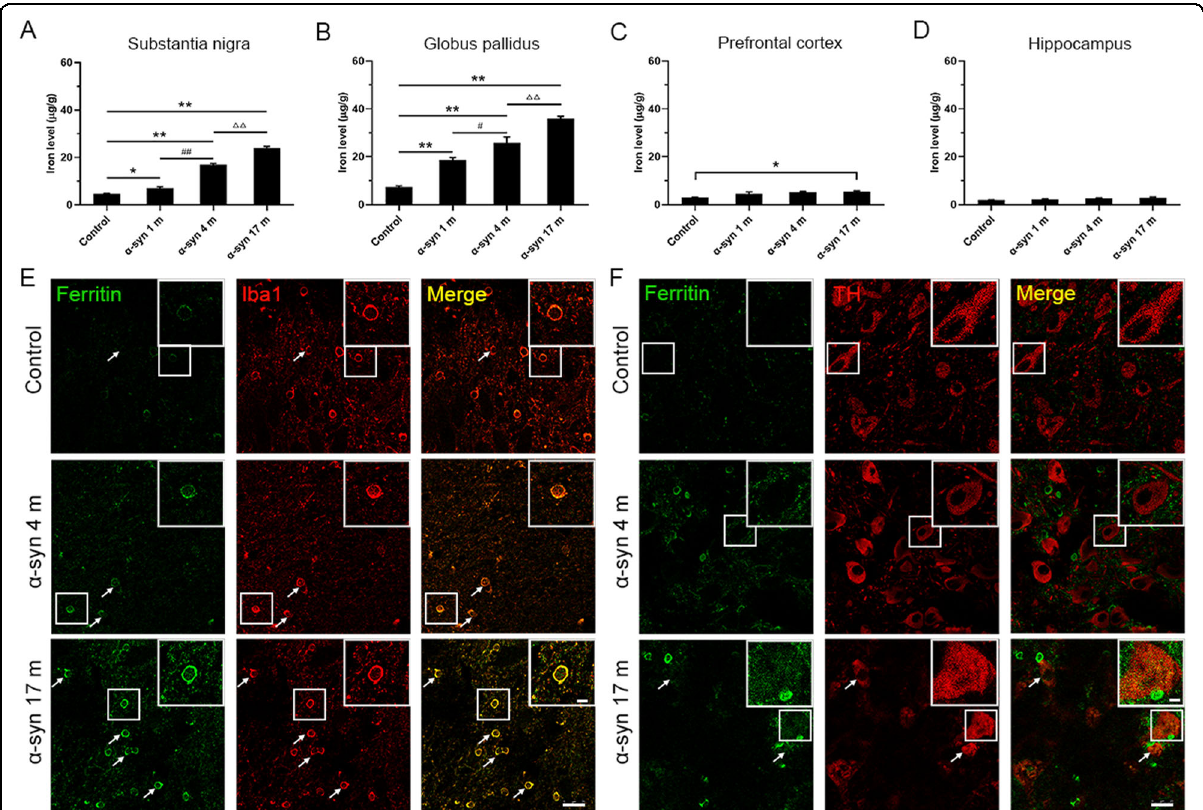
Fig. 3 Iron contents in different brain regions and ferritin in microglia and dopaminergic neurons. The iron content in the substantia nigra ( A ), globus pallidus ( B ), prefrontal cortex ( C ), and hippocampus ( D ) was determined by AAS. E Colocalization of ferritin and Iba1 in the substantia nigra. F Colocalization of ferritin and TH in the substantia nigra. The data are presented as the mean ± SEM of three independent experiments. α -Syn, α -synuclein. * p < 0.05 and ** p < 0.01 vs. control group, # p < 0.05 and ## p < 0.01 vs. 1-month group, ΔΔ p < 0.01 vs. 4-month group, one-way ANOVA. Scale bars: 25 μ m in E and F , and 25 µm in the